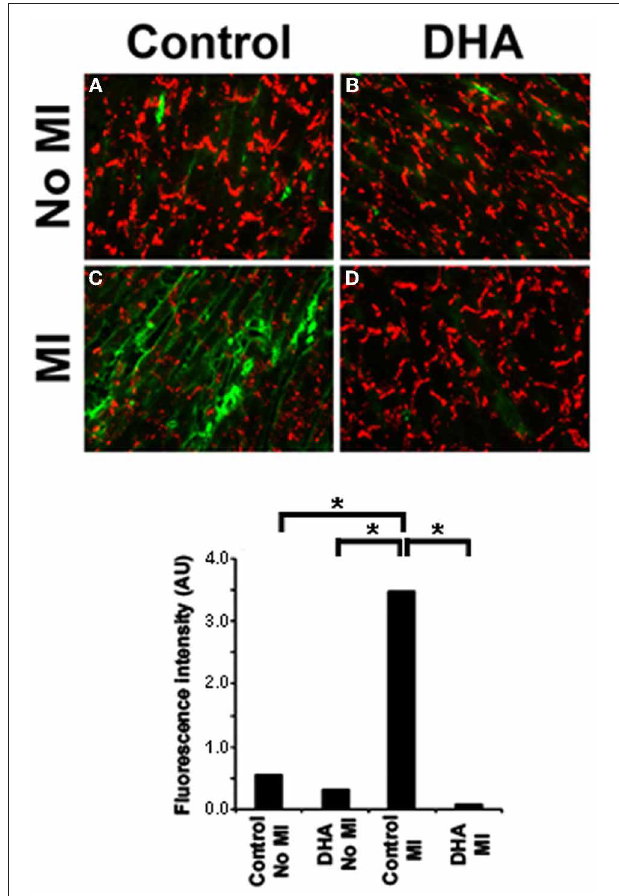
FIGURE 5 | Immunostaining for Cx43 (red) and SMA (green) in mice following coronary occlusion (CO) that received either a DHA or matched fat diet (Control). Control animals showed only very low levels of Smooth Muscle Actin staining regardless of their diet ( A and B ). In MI animals without DHA the number of SMA positive cells significantly increased after CO ( C , MI). DHA pretreatment caused SMA positive staining to be restricted to vessels (D) . Lower panel shows the quantification of SMA staining intensity. n = 3, p < 0 .